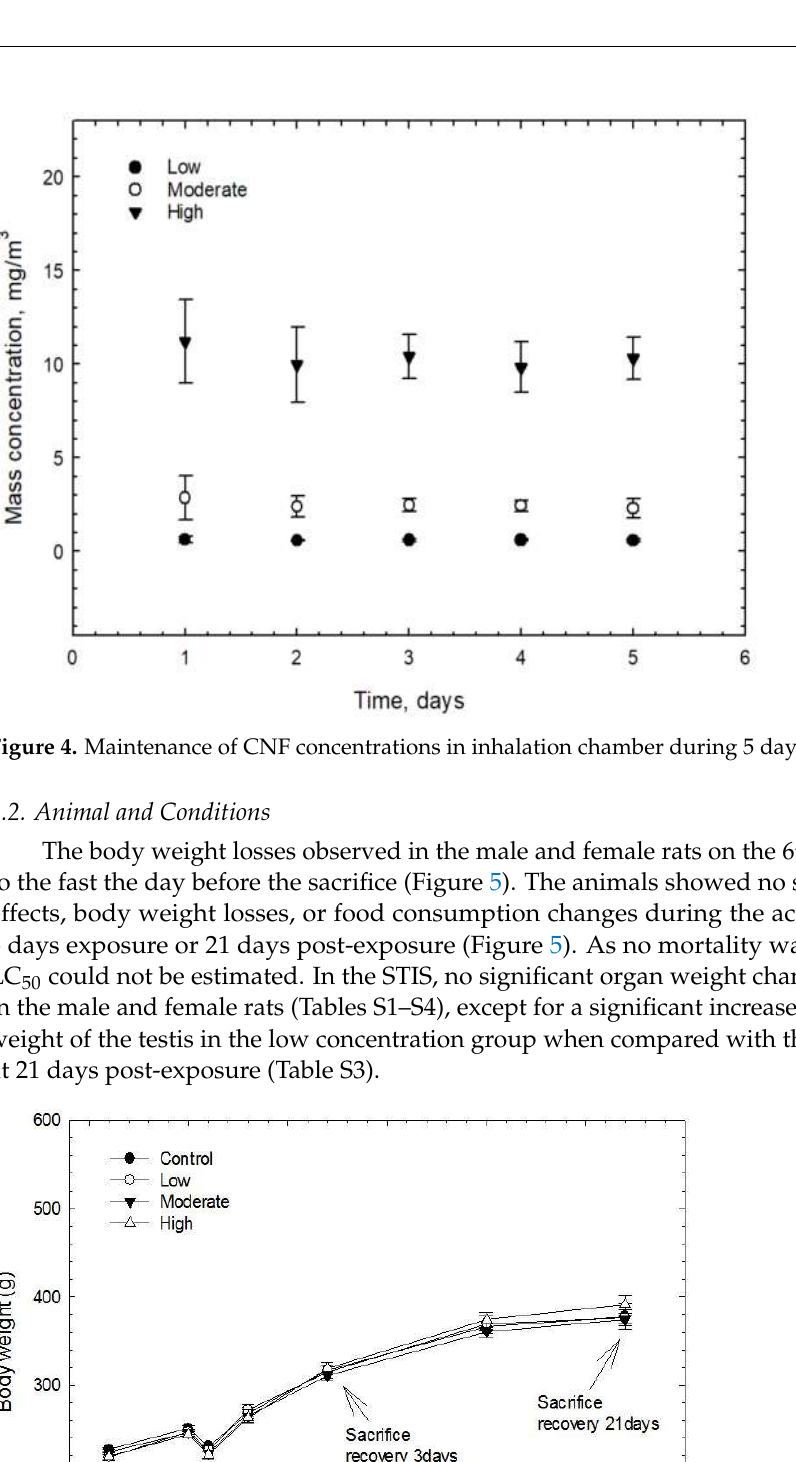
Figure 3. ( A – C ) FE-SEM analysis; ( A ) CNF agglomerates (scale: 100 μm); ( B ) high magnification of CNF mono-agglomerate (scale: 200 μm) ( C ) mono-fiber thickness (32~35 nm): ( D – F ) FE-TEM anal- ysis; ( D ) agglomerated state of CNFs (scale: 1 μm); ( E ) fibrous state of CNFs (scale: 200 nm); ( F ) high magnification of ( E ) (scale: 50 nm).